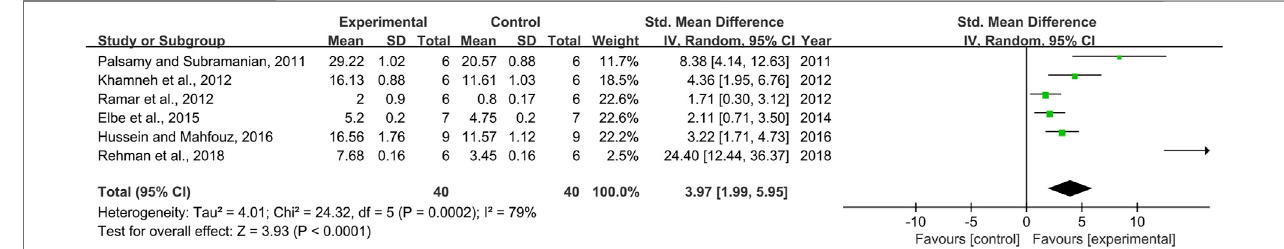
FIGURE 8 | Pooled estimate of GSH with RSV.